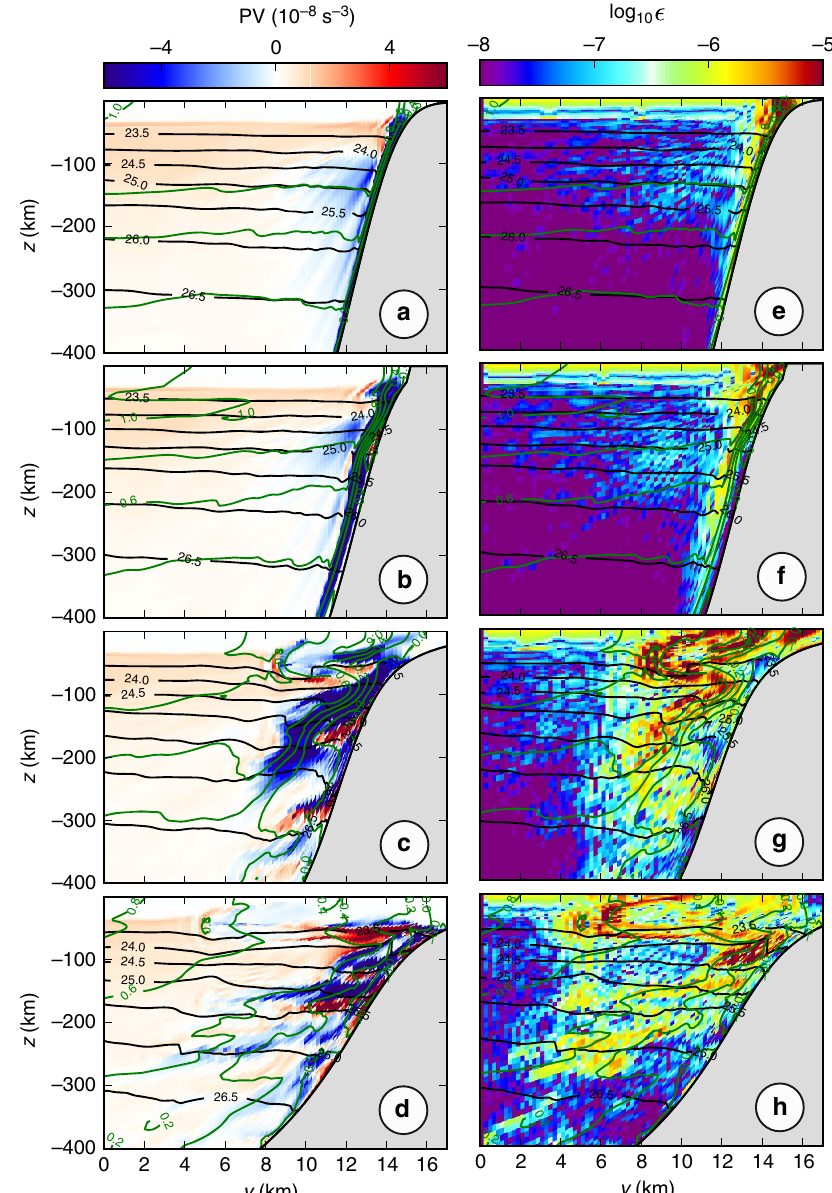
Figure 3 | Submesoscale centrifugal instability of the boundary layer. ( a – d ) Vertical sections of potential vorticity (PV, in 10 (cid:2) 8 s (cid:2) 3 ) and ( e – h ) energy dissipation E ð m 2 s (cid:2) 3 Þ from upstream to downstream along the Great Bahamas Banks (see yellow lines in Fig. 2) showing ( a , e ) PV generation, ( b , f ) separation from the slope, and ( c , d , g , h ) centrifugal instability in the wake. Density is shown in black contours with an interval of 0.5kgm (cid:2) 3 and along- slope velocity is shown in green contours with an interval of 0.2ms (cid:2) 1 .